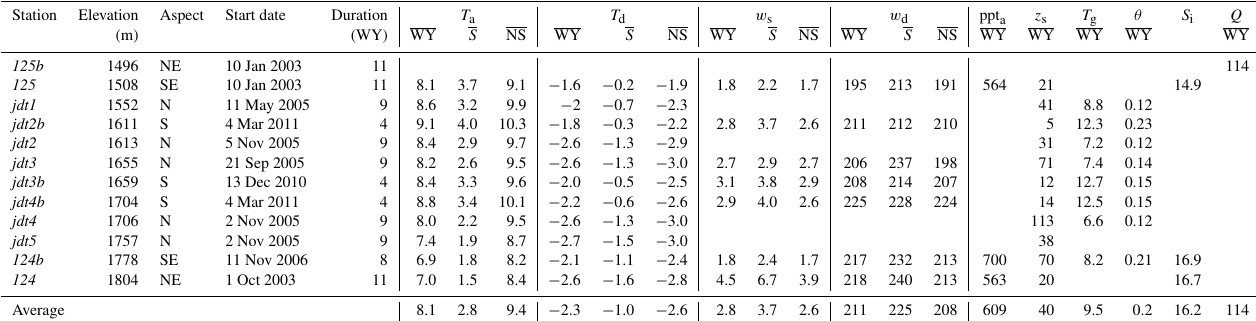
Table 1. Stations within Johnston Draw watershed, their elevations, and available parameters at each station. Although data presented in this dataset are limited to the end of WY2014 (30 September 2014), data from all stations continue further than WY2014 as all stations are currently maintained. Full station names used by the USDA ARS and recorded in the published dataset include the prefix “rc.tg.dc.jd-” before each abbreviated station name recorded in the first column of this table; however, for simplicity, these abbreviated station names are used throughout this paper. A full naming convention is provided in the Naming Convention file with the published dataset. Because T d was calculated based on RH (see text for details), RH is not summarized here, but is available at all stations except 125b (streamflow station). Start date is presented as DD-mmm-YYYY. T a – air temperature ( ◦ C), T d – dewpoint temperature ( ◦ C), w s – wind speed (ms − 1 ), w d – wind direction (0–359 ◦ , 0 = north; 180 = south), ppt a – wind-corrected precipitation (mm), z s – snow depth (mm), T g – soil temperature at 20cm depth ( ◦ C), θ – soil water or moisture at 20cm depth (m 3 m − 3 ), S i – incoming solar radiation (MJm − 2 day − 1 ), Q – streamflow (mm), WY = mean WY value, S = mean storm value, and NS = mean non-storm value. WY for T g and θ at 124b were calculated based on the two subsurface measurement locations at this site (see text for details). Note that S i and Q units have been converted from the database to the units reported here for comparison across parameters and sites. Snow depth is averaged over WY2011–2014 for all sites to facilitate meaningful comparisons.